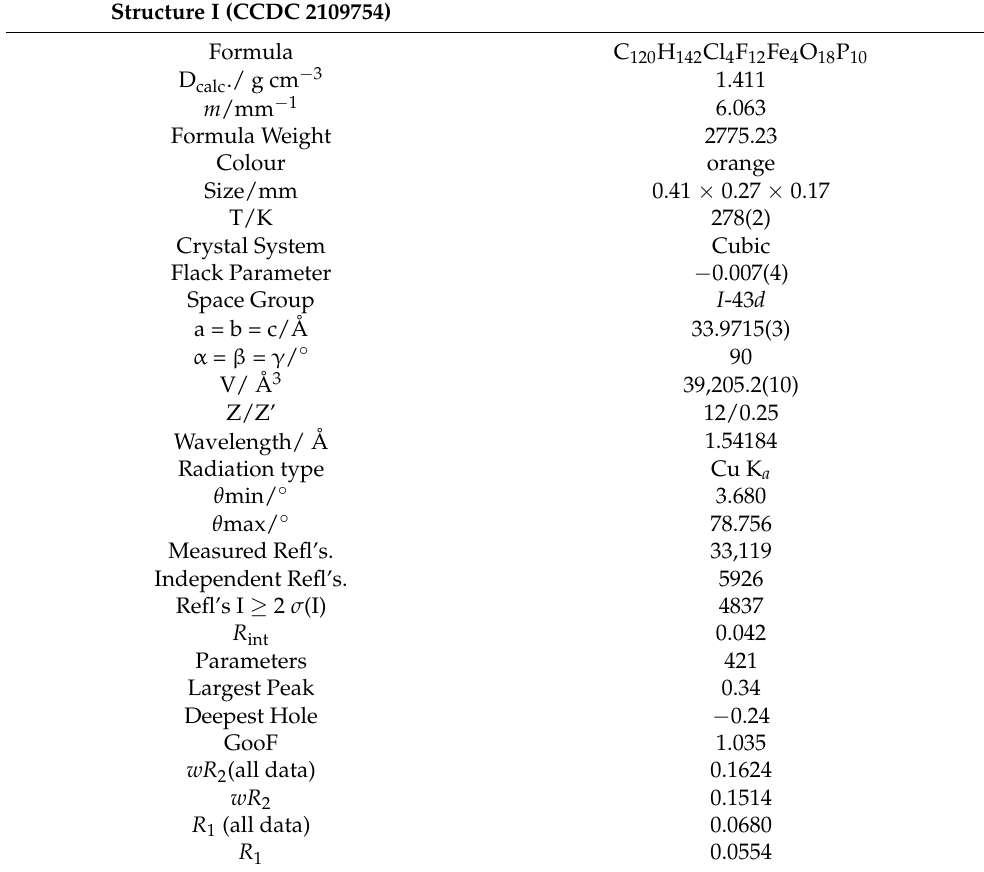
Table 1. Crystal data and structure refinement